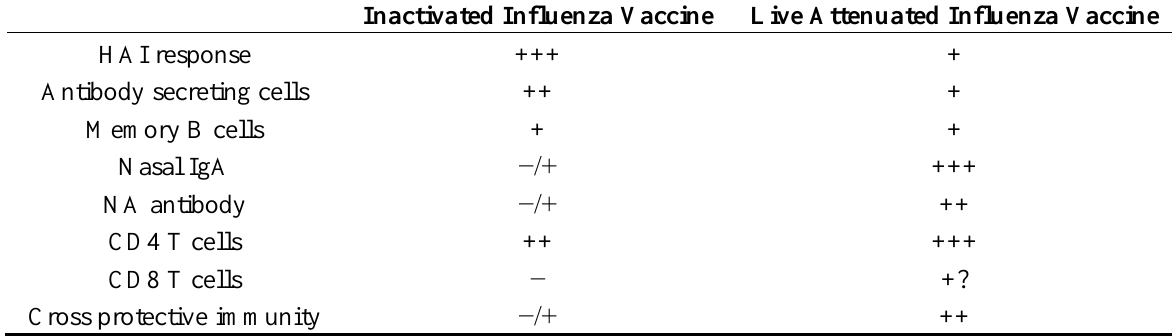
Table 3. Comparison of the immune response to inactivated influenza and live attenuated influenza